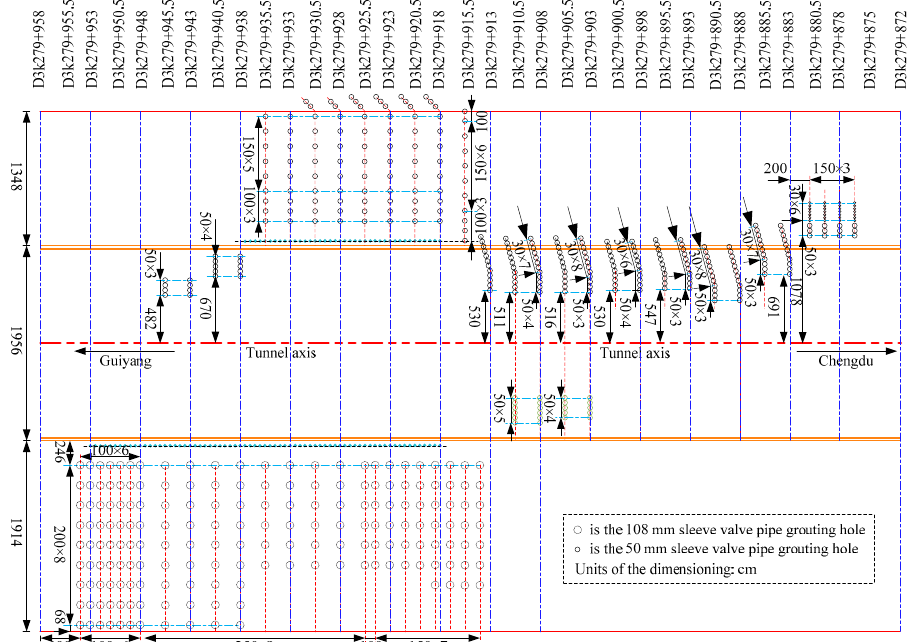
Figure 11. The arrangement of grouting holes.